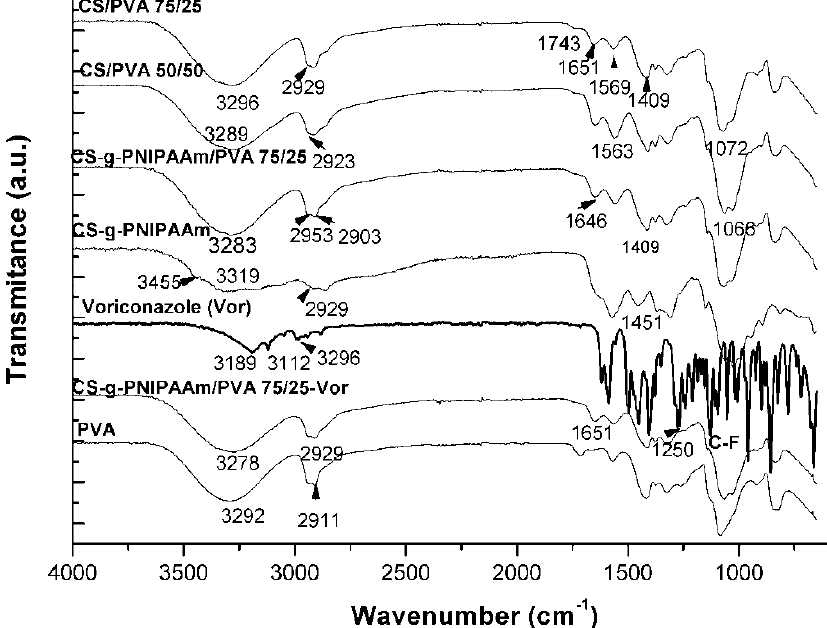
Figure 2. ATR–FTIR spectra of the freeze-dried hydrogels based on pure chitosan, PVA, and copolymer CS - g - PNIPAAm.